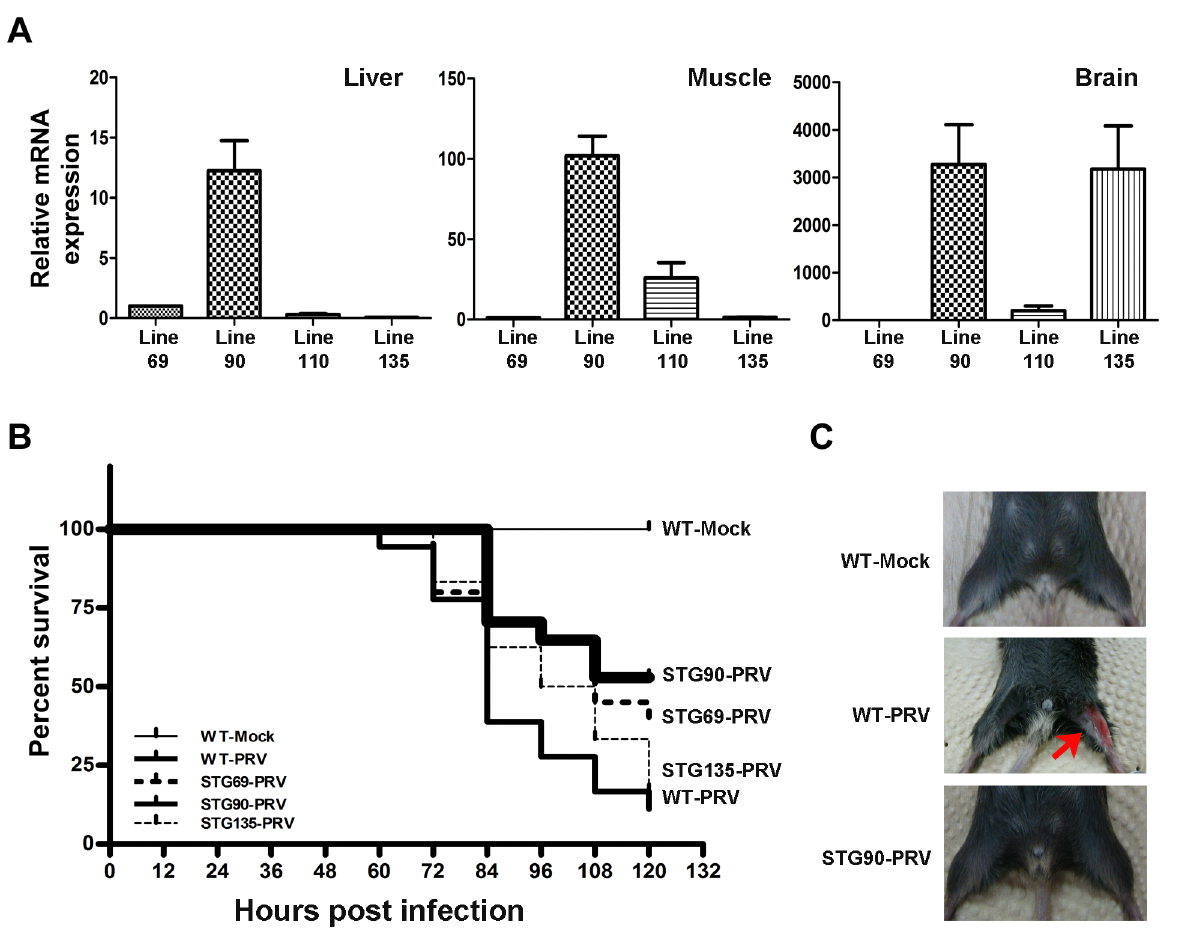
Figure 7. High expression of 3D8 scFv in the muscle and brain of STG90 mice. A . 3D8 scFv mRNA expression was verified by quantitative real-time reverse transcription polymerase chain reaction (RT-PCR) analysis in the muscle and brain of TG mice. The STG90 line expressed high levels of 3D8 scFv in both the brain and muscle, whereas the STG135 line expressed high amounts of 3D8 scFv in the brain; these strains were selected for further antiviral preventive studies. The relative expression of 3D8 scFv mRNAs was calculated after normalization to the GAPDH gene using the delta delta C T method. The primer efficiency of 3D8 scFv and GAPDH are 1.845 and 2.065, respectively. Each qRT-PCR data point is a representative example of data from three replicate experiments. Data bars represent mean 6 standard error. B . Kaplan-Meier survival analysis for antiviral effects of all groups. The difference in survival between WT-PRV and STG90-PRV was statistically significant (p=0.0042 by log-rank test). The numbers of live and dead mice were counted every 12 hr for 5 days after challenge with 10 LD 50 PRV in the femoral muscle. Survival was highest in the STG90-PRV group (53%) compared to that of the other groups (WT-PRV: 11%, STG69: 40%, and STG135: 17%). C . PRV-challenged F 2 mice (WT-PRV) began to exhibit symptoms of inflammation in the femoral muscle and finally died 3–5 days post-virus challenge. Red arrow points to inflammation